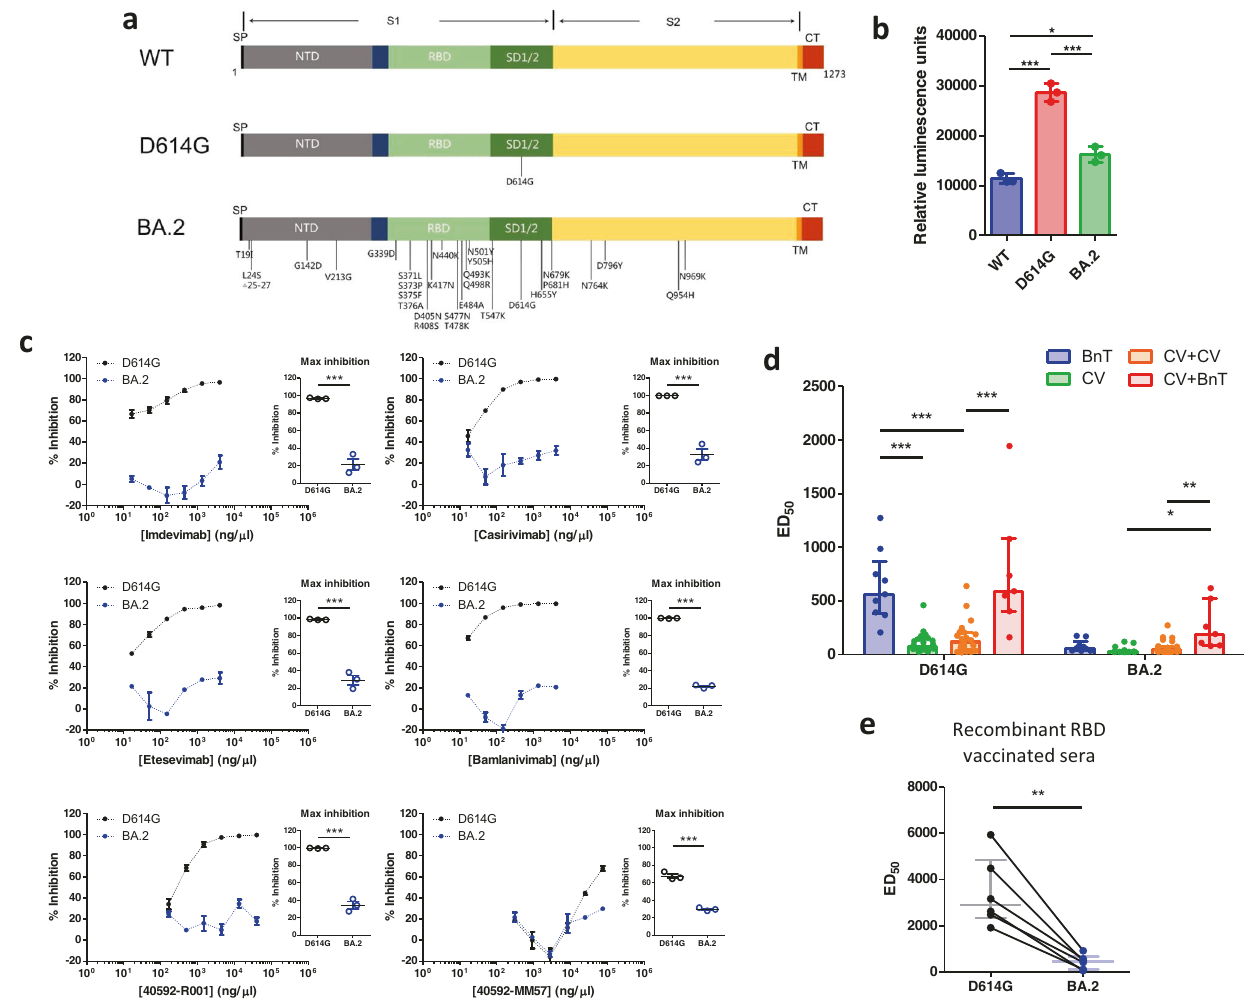
Fig. 1 a Topological schematic of the SARS-CoV-2 spike protein, highlighting the locations of the mutations, relative to the ancestral WT strain. The spike protein is divided into the S1 and S2 (yellow) regions. The S1 contains the signal peptide (SP), the N-terminal domain (NTD; gray), the receptor binding domain (RBD; light green) and the subdomains 1 & 2 (SD1/2; dark green). Also shown are the transmembrane domain (TM; orange) and the cytoplasmic tail (CT; red). b Mean luminescence recorded from HEK-293T cells stably expressing ACE2 and TMPRSS2 following infection by pseudoviruses containing different spike proteins. Statistical analysis was performed using a one-way ANOVA ( P < 0.0001). Post-hoc pairwise comparisons were performed using the Bonferroni correction (* P < 0.05; *** P < 0.0001). c Neutralizing activity for six monoclonal antibodies against D614G (black) and BA.2 (blue) pseudoviruses. Concentration-inhibition relationships of each monoclonal antibody are shown. Individual data points were joined with a straight line. No sigmoidal function was fi tted to the data. Maximum inhibition of D614G or BA.2 pseudovirus entry into HEK-293T-AT cells were compared using a t-test (inset scatter plots). Data which signi fi cantly differed from each other are indicated using asterisks (*** P < 0.0001). d Bar graph showing median [IQR] of ED 50 from recipients of different vaccination regimens (BnT: two-dose BnT162b2, CV: two-dose CoronaVac, CV + CV: two-dose CoronaVac + CoronaVac booster, CV + BnT: two- dose CoronaVac + BnT162b2 booster). The data was compared with a two-way ANOVA. We fi nd signi fi cant differences in the variant factor ( P < 0.0001), vaccine factor ( P < 0.0001) as well as signi fi cant interaction ( P < 0.0001). We compared pairwise differences between different vaccination regimens using a Bonferroni post-hoc analysis. Data which signi fi cantly differ from each other are indicated using asterisks (* P < 0.05; ** P < 0.001, *** P < 0.0001) e ED 50 changes in neutralization activity on D614G and BA.2 pseudoviruses of sera from monkeys immunized with a RBD recombinant protein vaccine. Horizontal line and error bars indicate median and IQR, respectively. The data were compared with a paired t -test ( P <